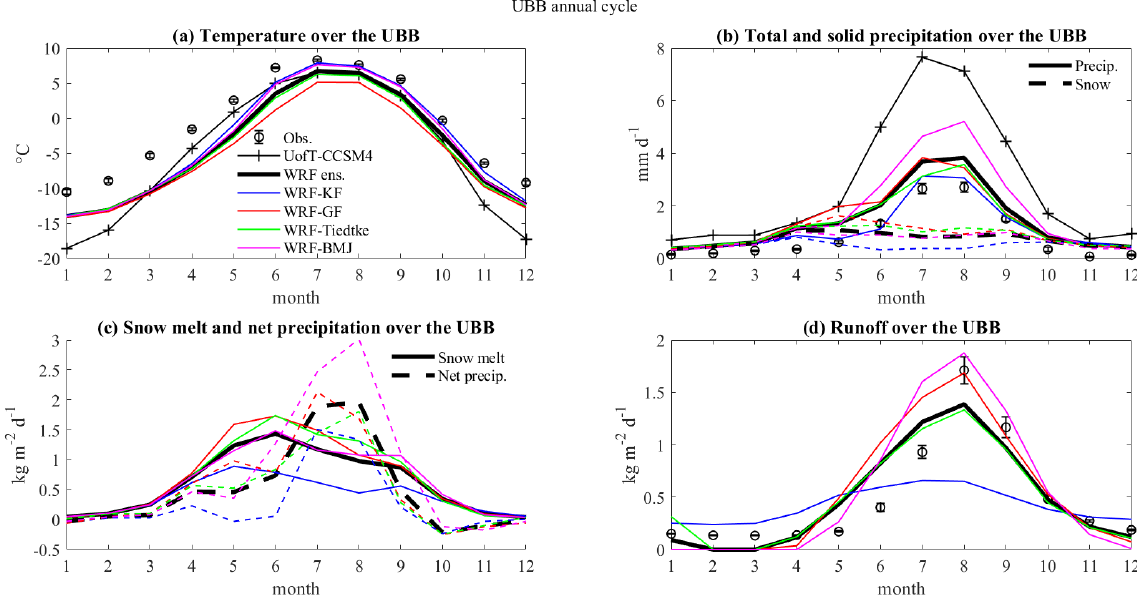
Figure 10. The same as in Fig. 8 but for the